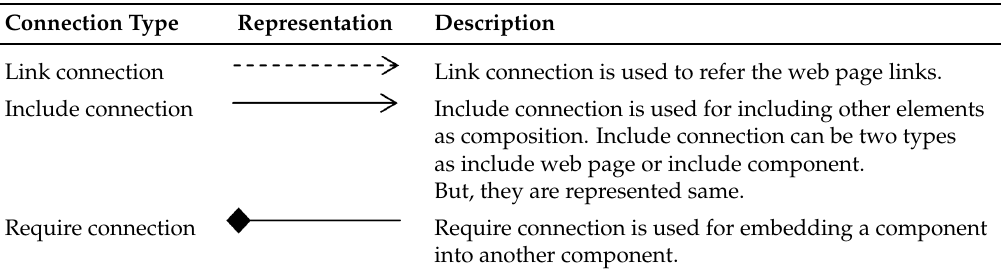
Table 3. The connection types in CPImeta.